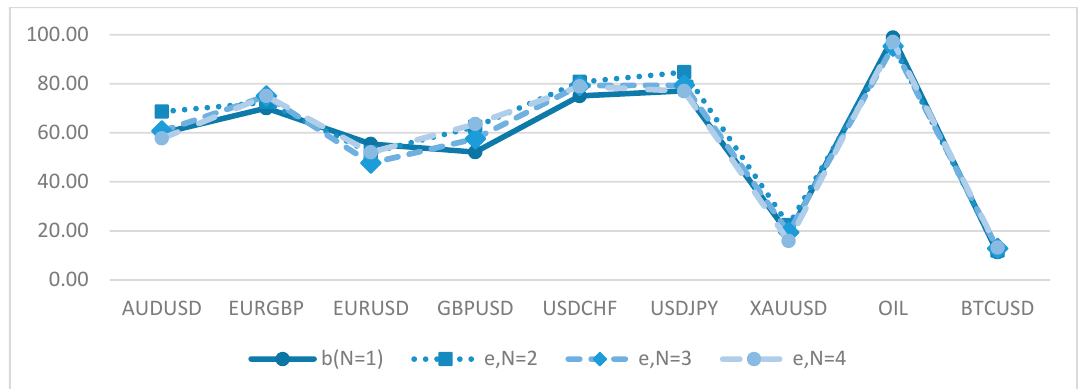
Figure 10. Net Profits of experiment (e) for various values of N.